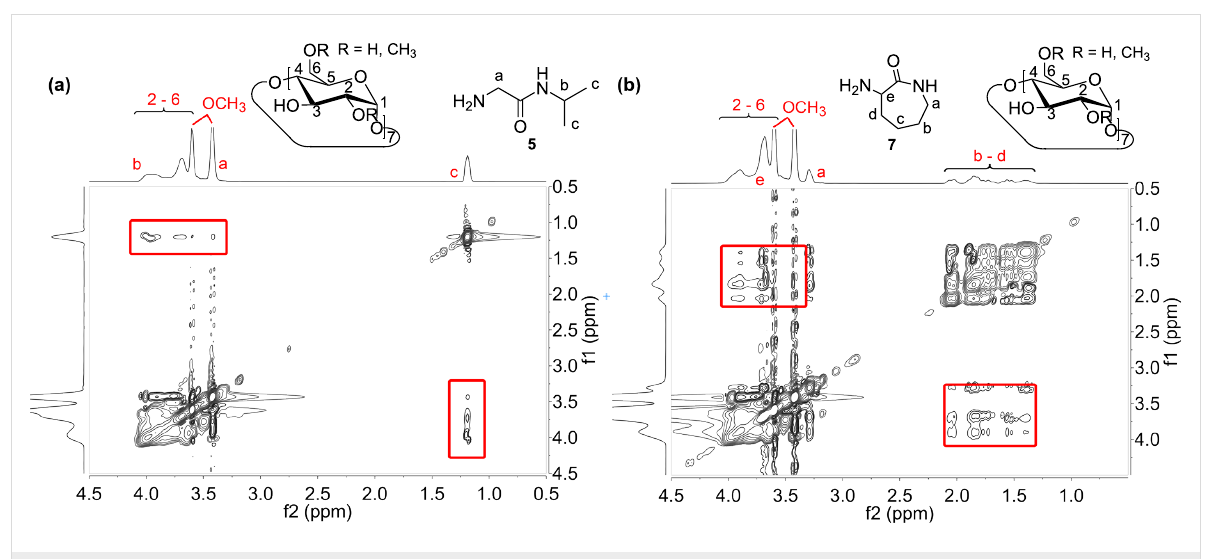
Figure 3: 2D NMR ROESY (300 MHz, D 2 O) spectrum of the complex of 5 with RAMEB-CD (a), displaying the correlation of the isopropyl moiety with RAMEB-CD and of 7 with RAMEB-CD (b), illustrating the interaction of the lower lactam ring with RAMEB-CD.